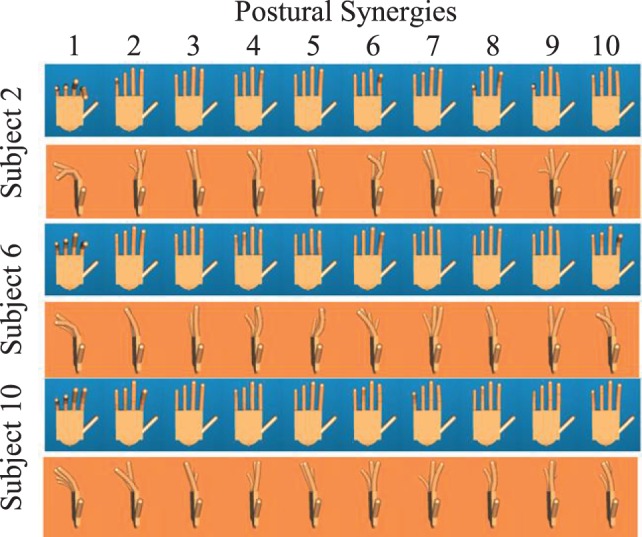
Front and side views of the 10 postural synergies for subjects 2, 6, and 10 are shown. Subjects were first trained on performing each of these postures. Then, images of the hand imitating these postures were taken.